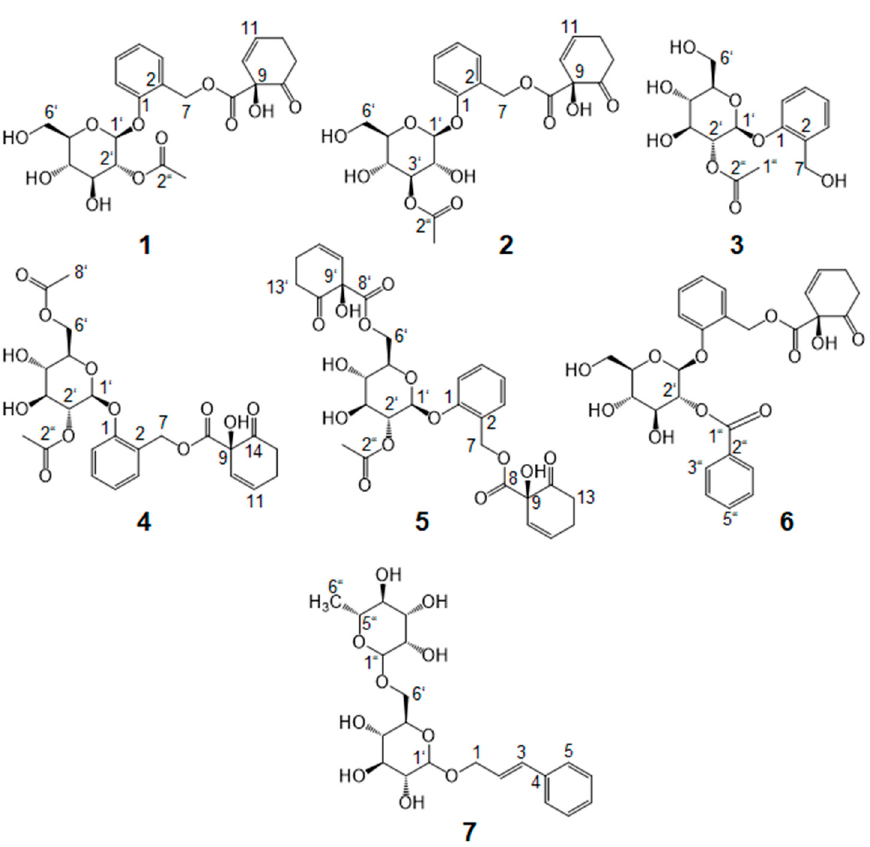
Figure 3. Chemical structures of isolated salicylates from the methanol extract of S. pentandra bark: 2 ′ - O -acetylsalicortin ( 1 ), 3 ′ - O -acetylsalicortin ( 2 ), 2 ′ - O -acetylsalicin ( 3 ), 2 ′ ,6 ′ - O -diacetylsalicortin ( 4 ), lasiandrin ( 5 ), tremulacin ( 6 ), and a non-salicylate cinnamrutinose A ( 7 ). 2 ′ - O -acetylsalicortin ( 1 ), purified from fraction F5-5-7, was analyzed by means of